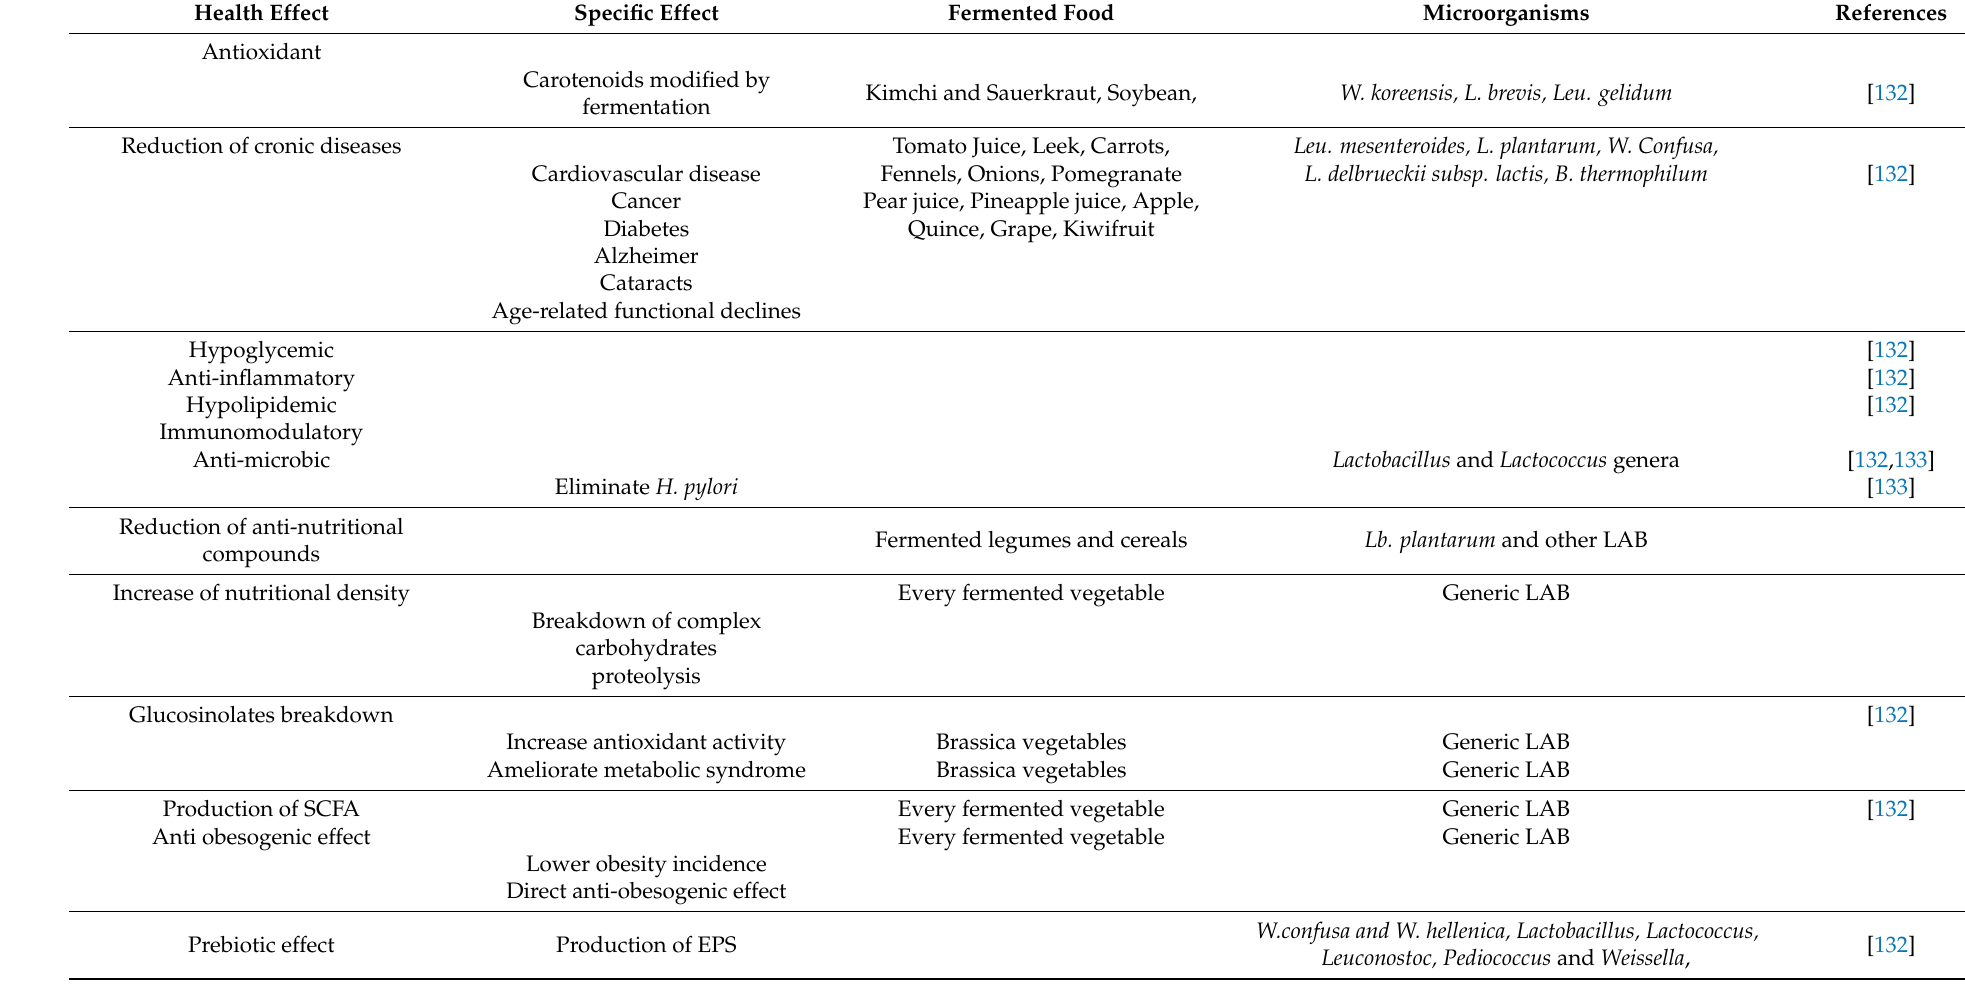
Table 3. Health-related effects of fermented vegetables